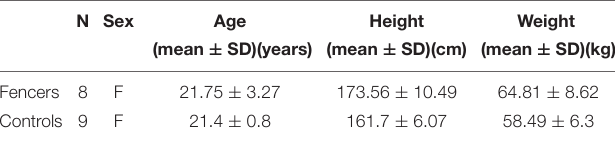
TABLE 1 | Physical characteristics of